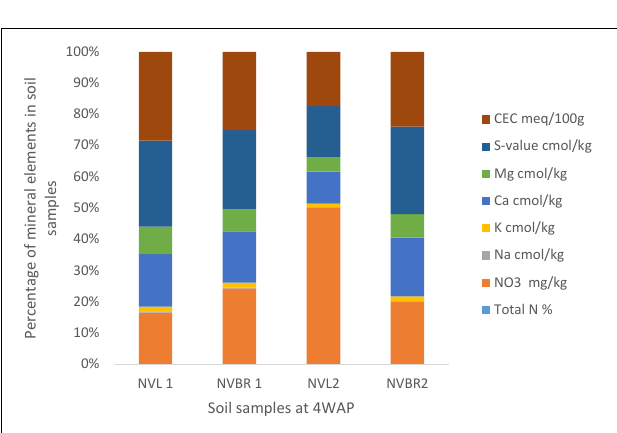
FIGURE 3 | Physical and chemical analysis of soil samples at 4 WAP. Nitrate (NO3) and CEC were the highest quantity of mineral found in the soil samples, and both were found in NVL2 and NVL1, respectively. N, November; VL and VBR, variety of Bambara from whose root, soil samples (NVL1, NVL2, NVBR1, NVBR2) were